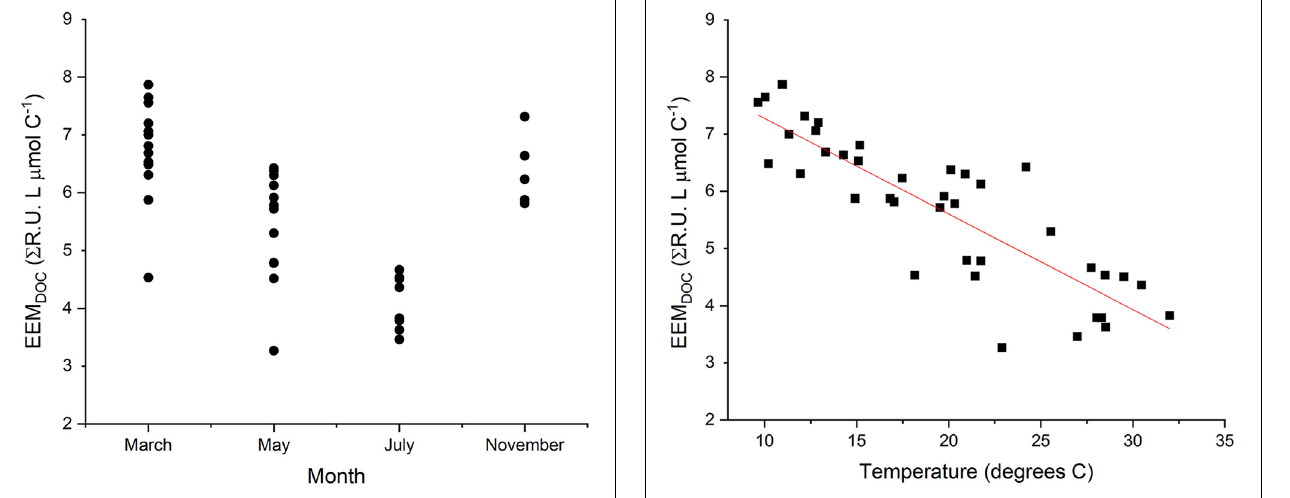
FIGURE 7 | The EEM DOC parameter ( n = 39) integrates the total response volume for each EEM; normalized to DOC concentration, it provides a relative estimate of the amount of fluorescent DOC present, in proportion to total DOC concentration, thus reflecting the proportion of DOC that can be resolved by using optical measurements.